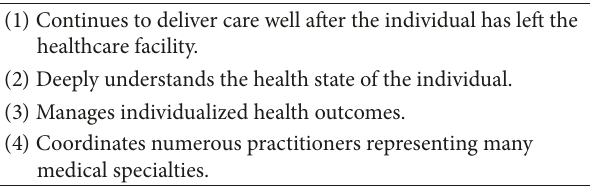
Table 2: New healthcare delivery system